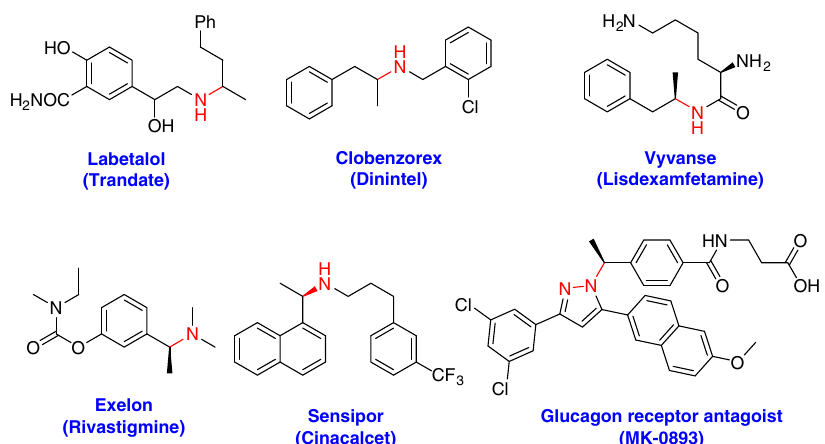
Fig. 1 Amine-containing drugs. Representative examples of pharmaceutical and biologically active compounds of amine derivatives.